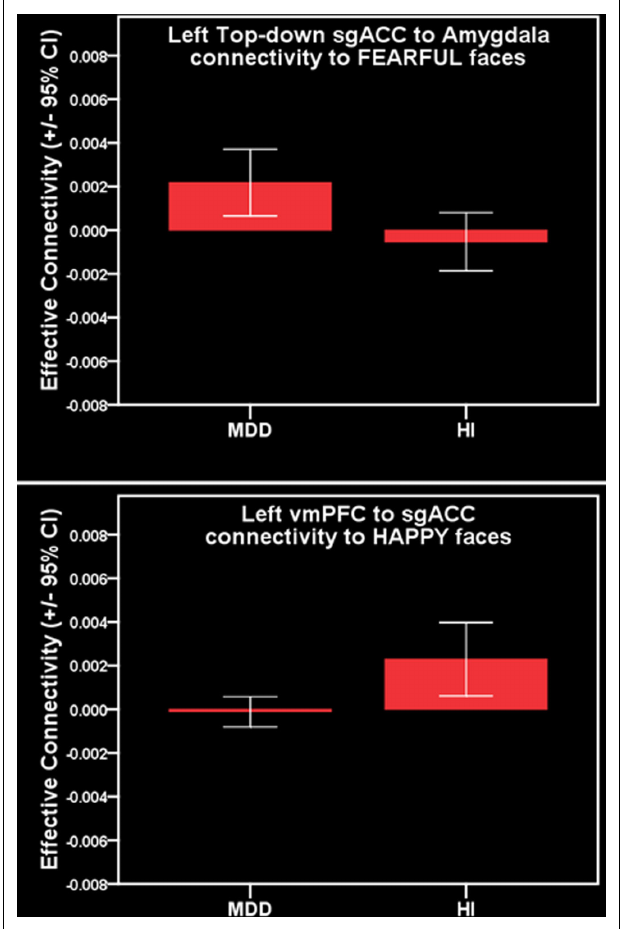
FIGURE 4 | Parallel analysis. Top: greater positive left-sided sgACC–amygdala connectivity to fearful faces in females with MDD. Bottom: reduced positive left-sided vmPFC–sgACC connectivity to happy faces in females with MDD.